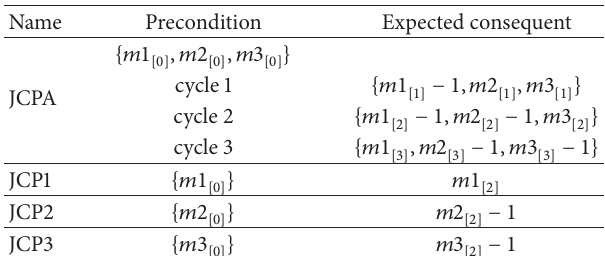
Figure 4: Johnson counter with error.